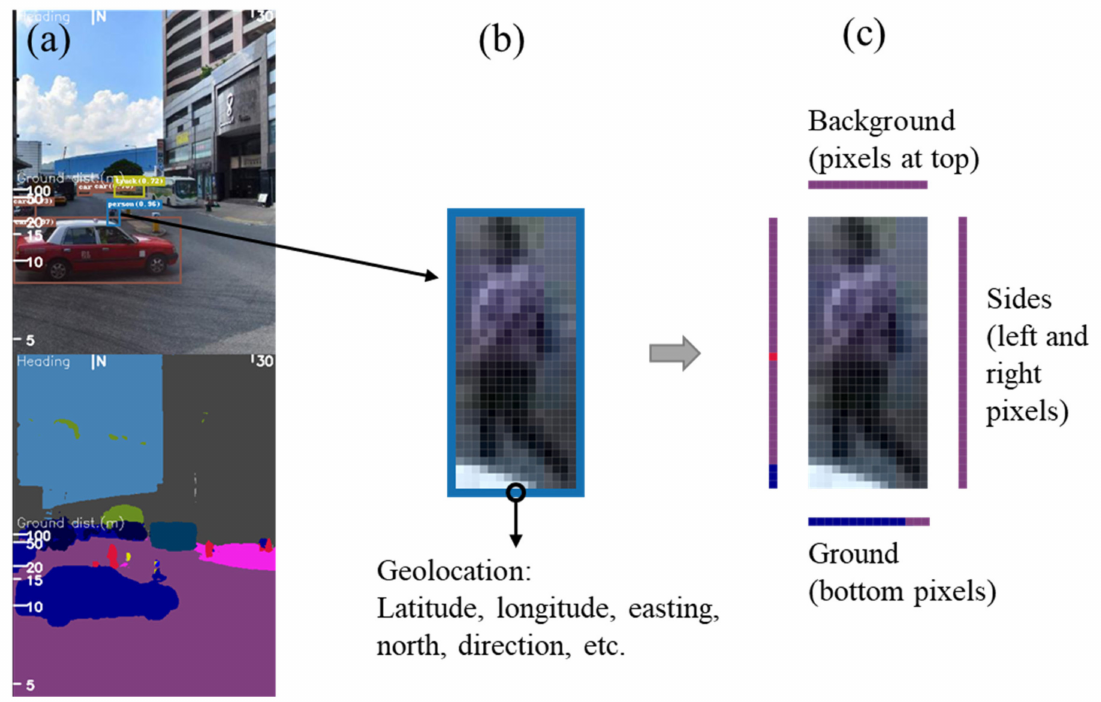
Figure 6. Extracting pedestrians, geolocations, and the surrounding semantic features, ( a ) results of transfer CNN and R-CNN, ( b ) a pedestrian’s geolocation extracted by the bounding box, ( c ) the pixels of ground, background, and